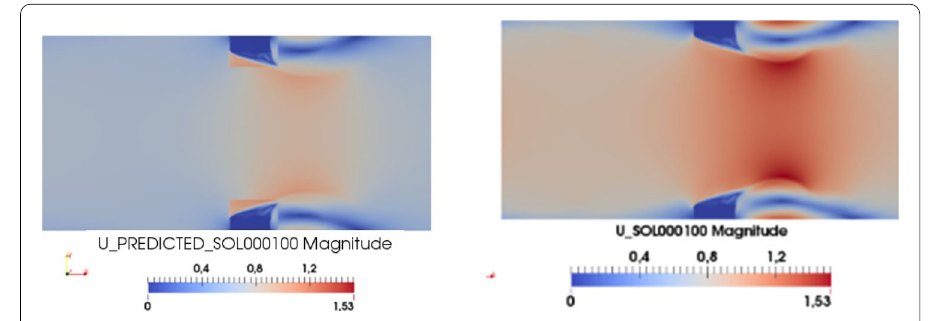
Fig. 6 On the left, the final time step predicted flow field U predicted ( t final ,G New ) by Gappy-POD. On the right, U ( t final ,G New ) the final time step 2D laminar incompressible flow in the new channel configuration